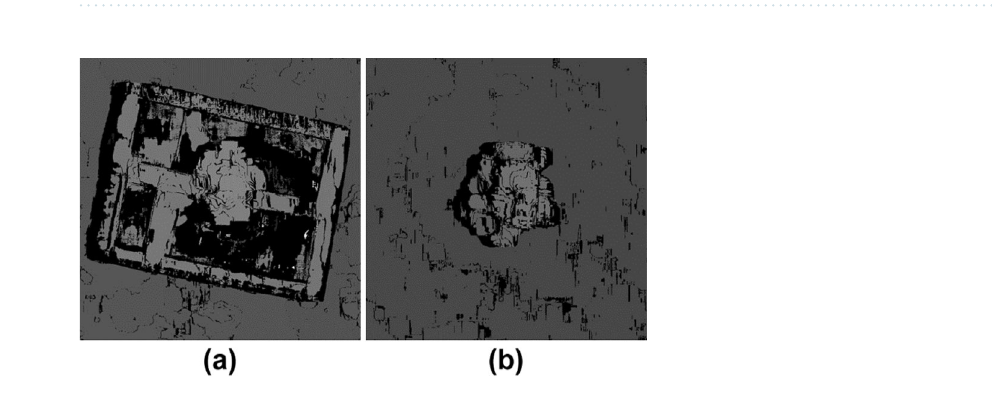
Figure 8. Disparity map obtained from two images in Fig. 6.